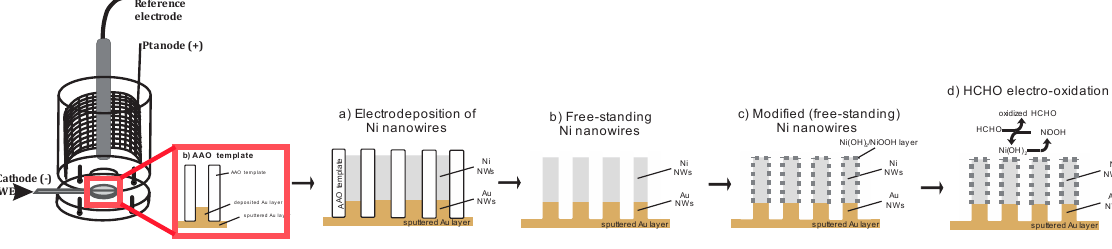
Figure 1. Scheme of the Teflon electrolytic cell and illustration of all experimental processes that were used before the studies of HCHO